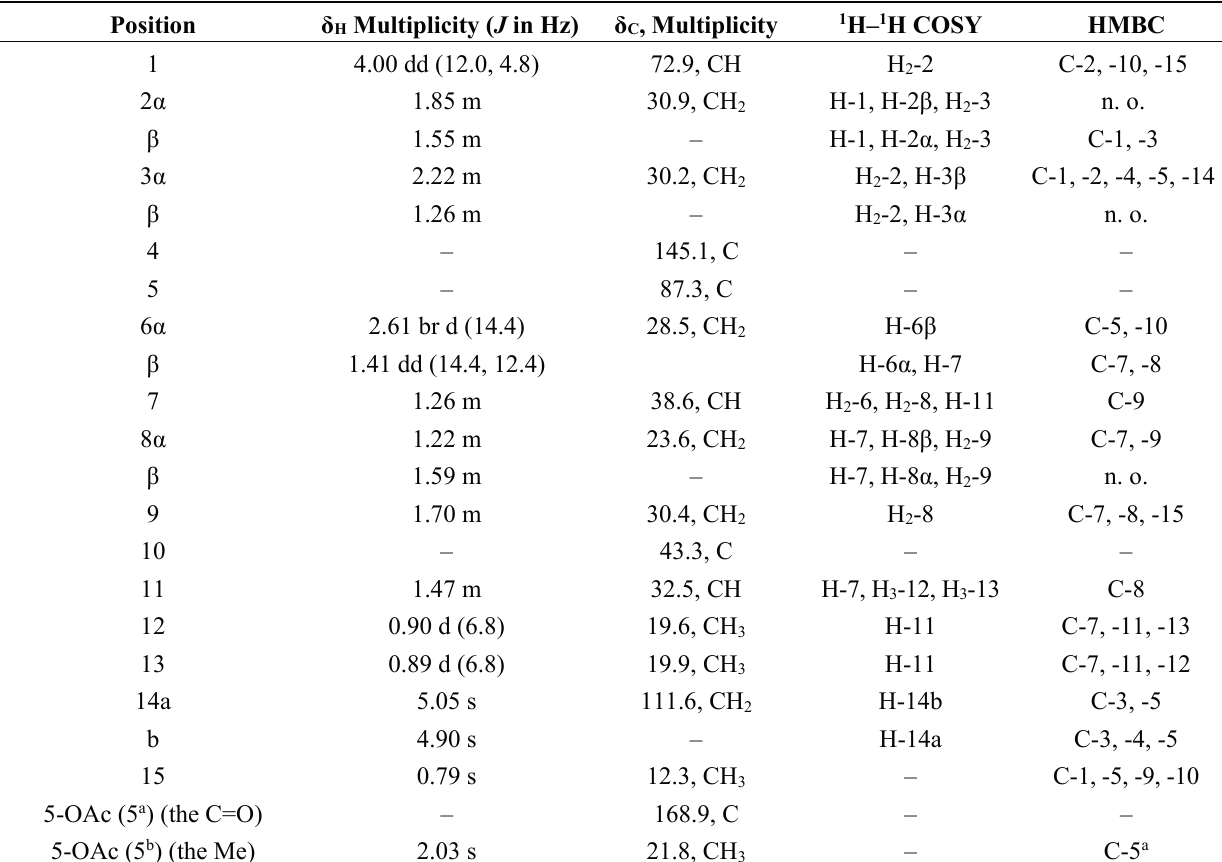
Table 1. 1 H (400 MHz, CDCl 3 ) and 13 C (100 MHz, CDCl 3 ) NMR data, 1 H– 1 H COSY and HMBC correlations for sesquiterpenoid 2